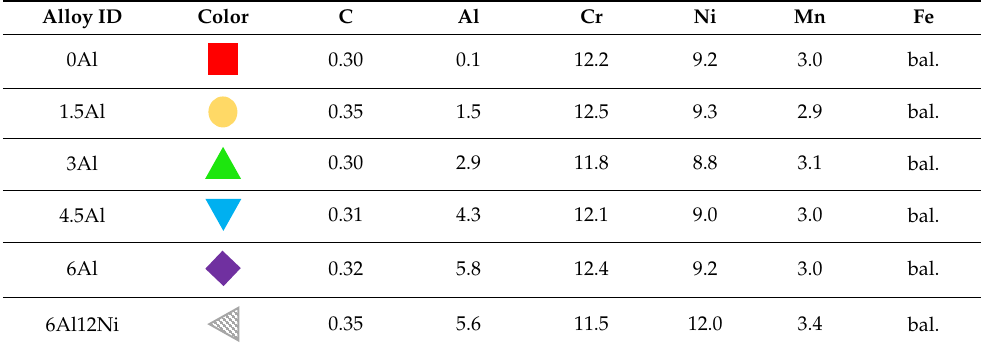
Table 1. Alloy IDs and chemical compositions (wt.%).